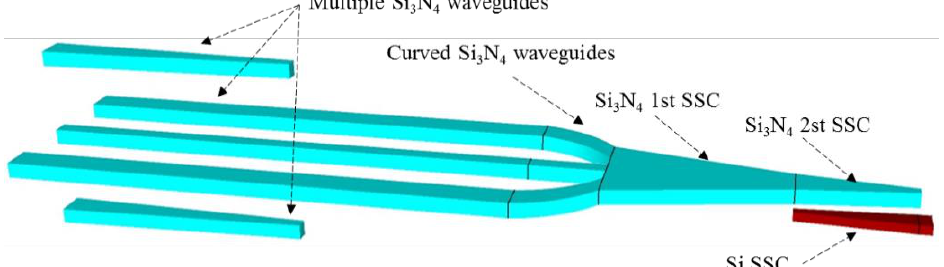
Figure 1. Schematic of the designed edge coupler.